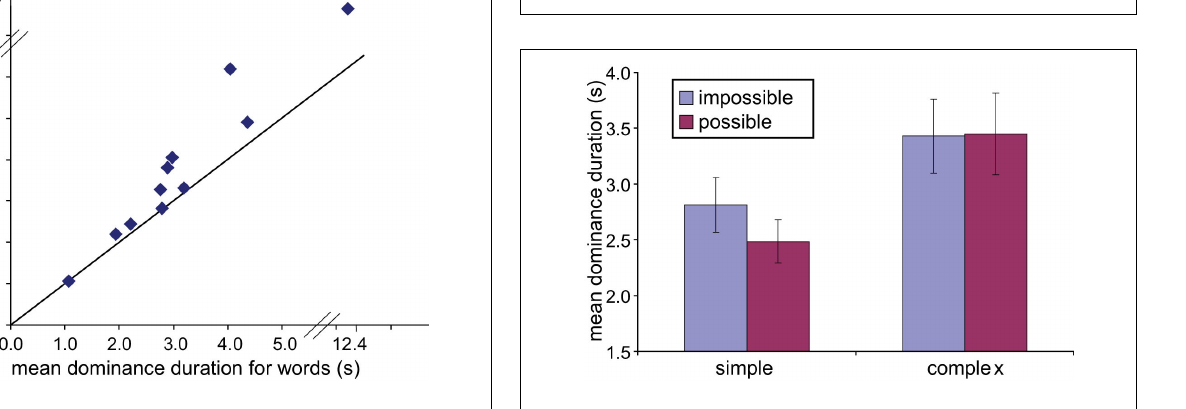
FIGURE 4 | Examples of stimuli used for possible vs. impossible figures. Simple and complex figures (top and bottom row, respectively) were used. Subjects viewed pictures through red/green filtered glasses.